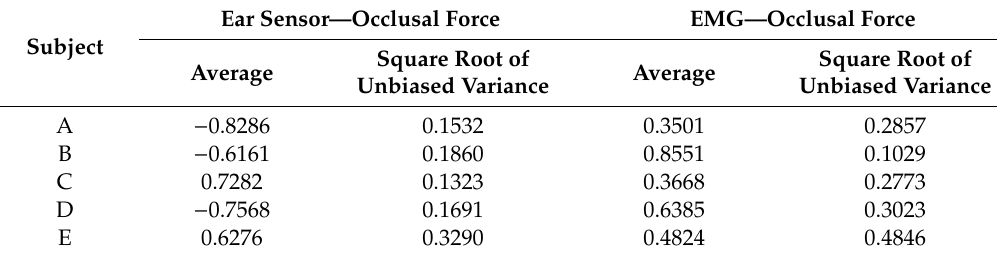
Table 2. Results for partial correlation coe ffi cients. Based on the results given in Table 1, the average and square root values of the unbiased variance of the partial correlation coe ffi cient over six runs while eliminating the e ff ect of the EMG value from the correlation coe ffi cient between the ear sensor value and the occlusal force are given; the average and square root of the unbiased variance of the partial correlation coe ffi cient over six runs while eliminating the e ff ect of the ear sensor value from the correlation coe ffi cient between the EMG value and the occlusal force are also